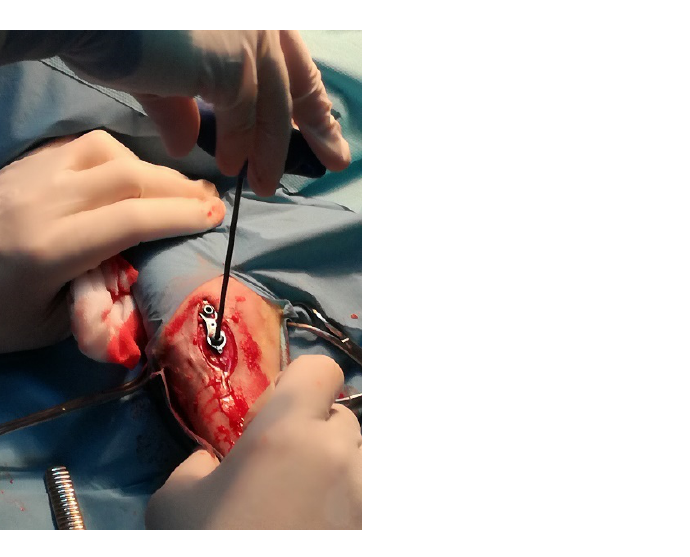
Figure 2. The implantation of titanium plate into the tibial growth plate in sheep.